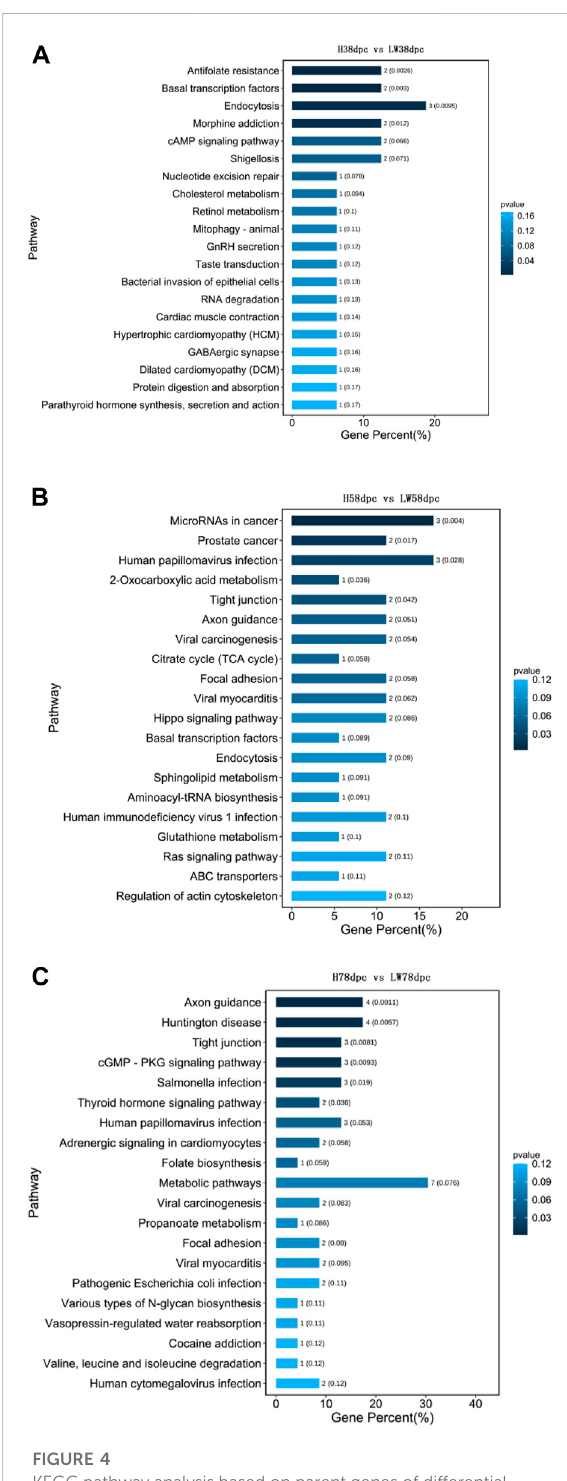
FIGURE 4 KEGG pathway analysis based on parent genes of differential circRNAs at 38 dpc (A) , 58 dpc (B) , and 78 dpc (C)